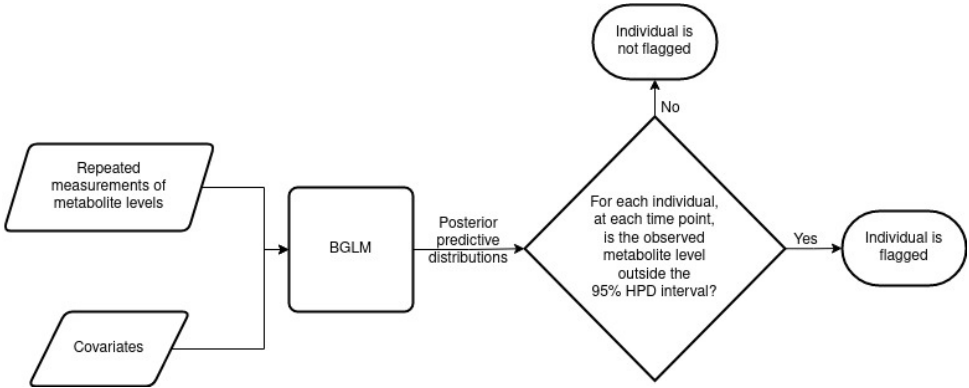
Figure 1. An overview of the MetaboVariation